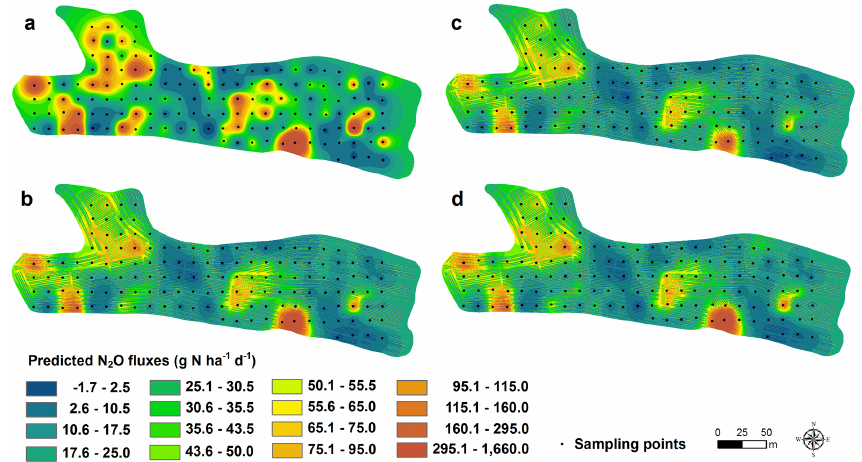
Figure 9. Spatial distributions of the N 2 O fluxes as predicted by (a) OK, (b) RK with chamber placement position as the regression predictor, (c) CK with SOCt (with the influence of chamber placement position detrended) as the covariable, and (d) CK with NH4Nt (with the influence of chamber placement position detrended) and NO3Nt (with the influence of chamber placement position detrended) as two covariables. Here, SOCt, NH4Nt and NO3Nt represent the logit-transformed soil organic carbon, soil ammonium and soil nitrate contents, respectively.